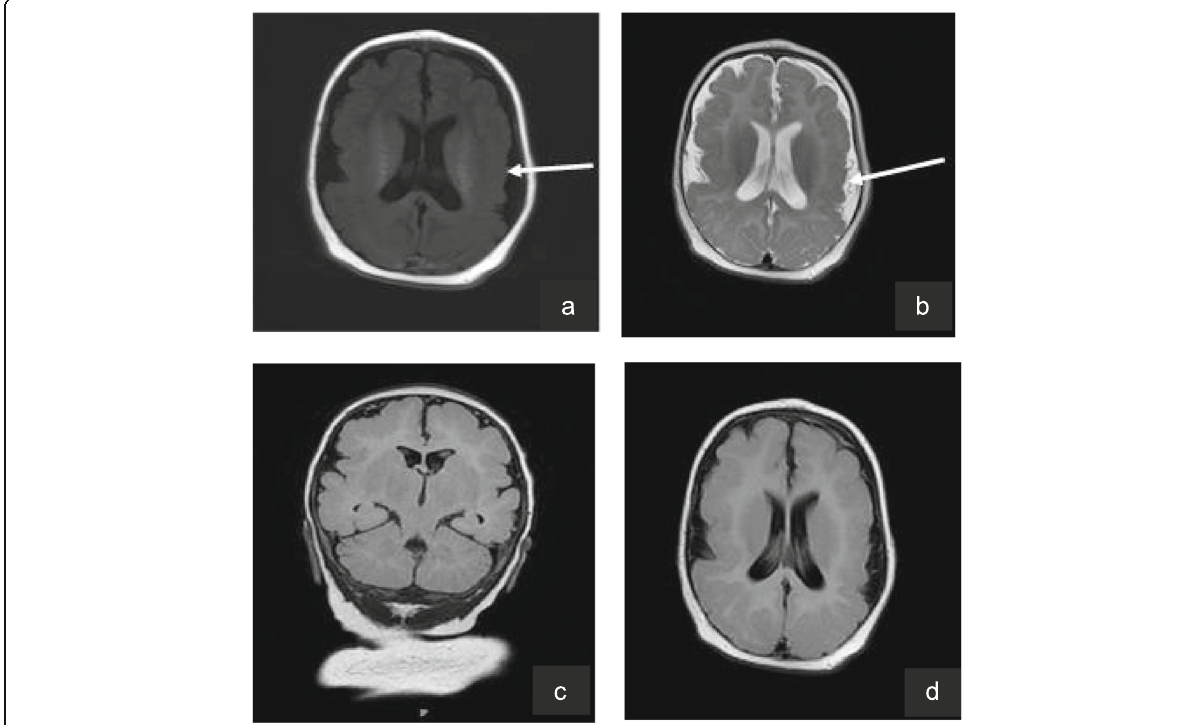
Fig. 1 Brain magnetic resonance imaging (MRI) of the patient. Shallow sulci, widened gyri and thickened bilateral cerebral cortex were noticed in bilateral hemispheres, and polymicrogyria in some areas. (the arrow) a : Axial T1; b : Axial T2; c : Coronal T2 FLAIR; d : Axial T2